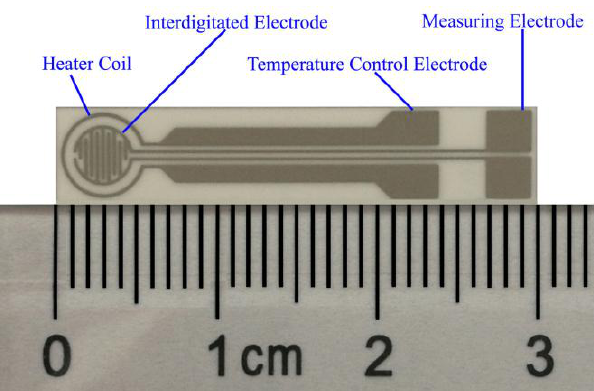
Figure 1. The substrate structure of the gas sensor. Table 1. The structure of the gas sensors.